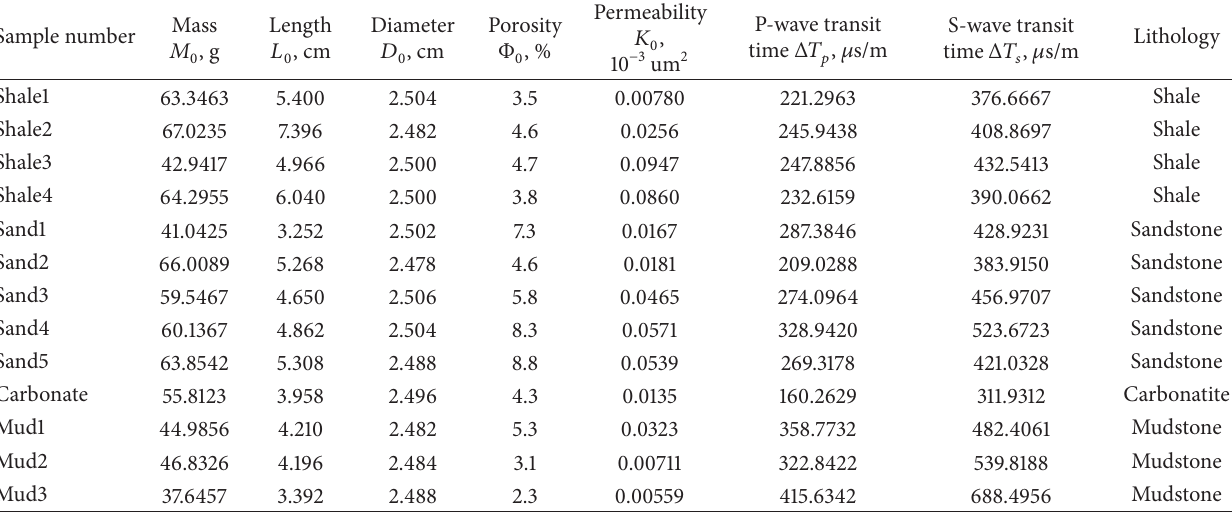
Table 1: Physical properties of samples without any heat treatment.